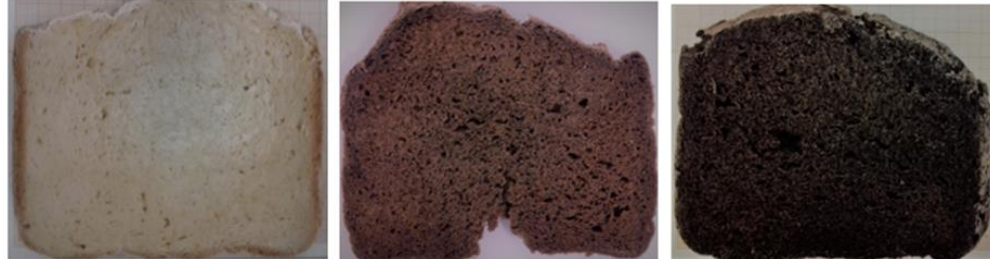
Figure 2. Cross section of elaborated gluten-free breads: (left) control bread (B1), (center) bread enriched with 3% of isolated coffee cascara dietary fiber (B2), (right) bread enriched with 4.5% of isolated coffee cascara dietary fiber (B3).